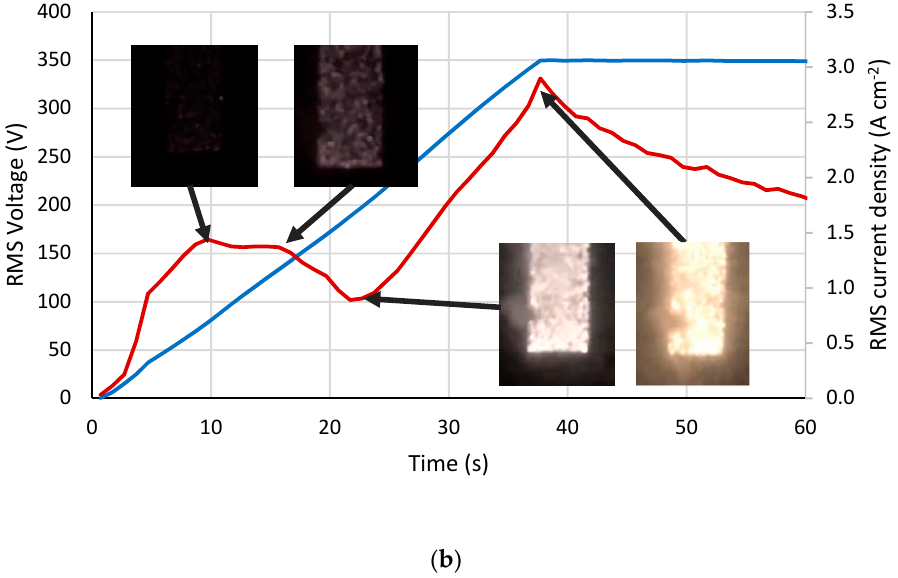
Figure 1. Evolution of RMS values of the voltage (blue) and current density (red), and microdischarges during the PEO process: ( a ) during all the treatment time; ( b ) during the initial stage of the process.